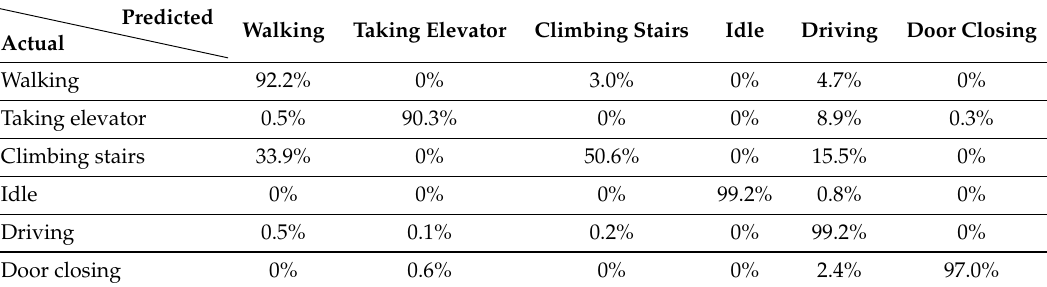
Table 7. Confusion matrix for the UCD